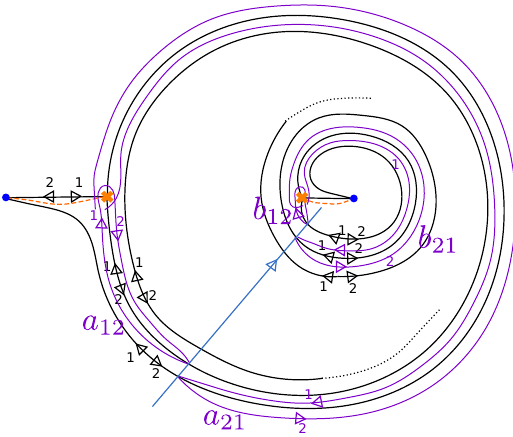
Figure 75 . Basic constituents of open paths f p g on e C . The (minimal) detours a 12 ; a 21 ; b 12 ; b 21 are shown in purple.